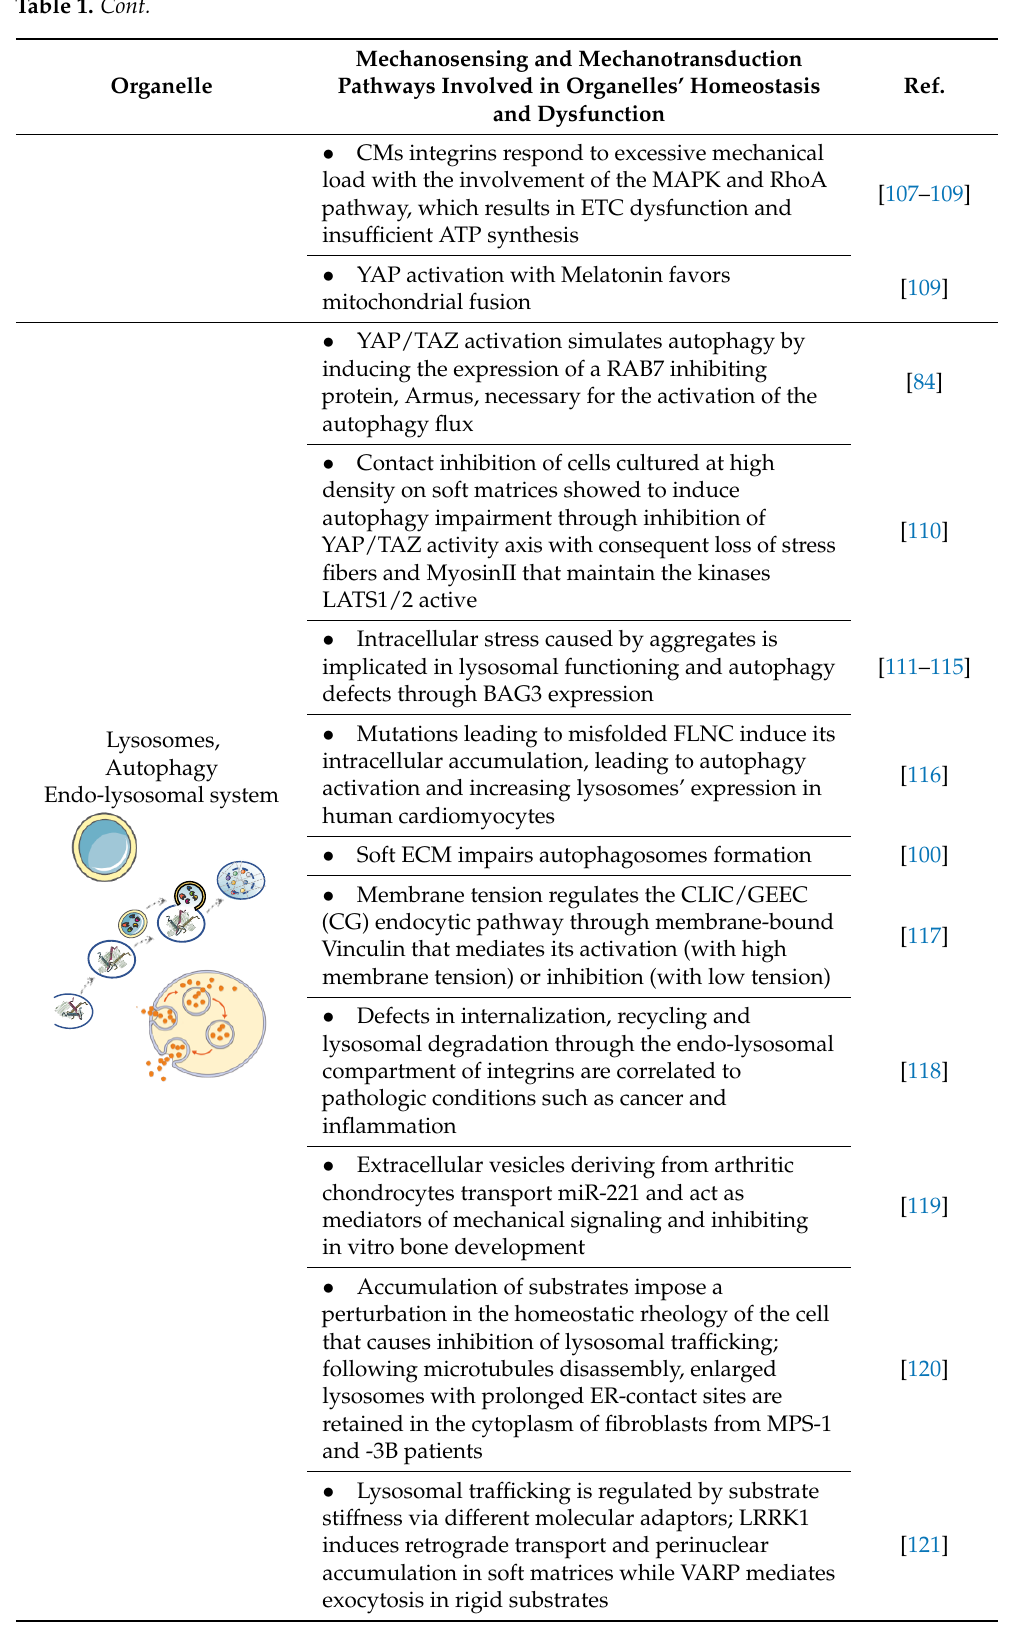
Table 1. Cont. Mechanosensing and Mechanotransduction Organelle Pathways Involved in Organelles’ Homeostasis and Dysfunction